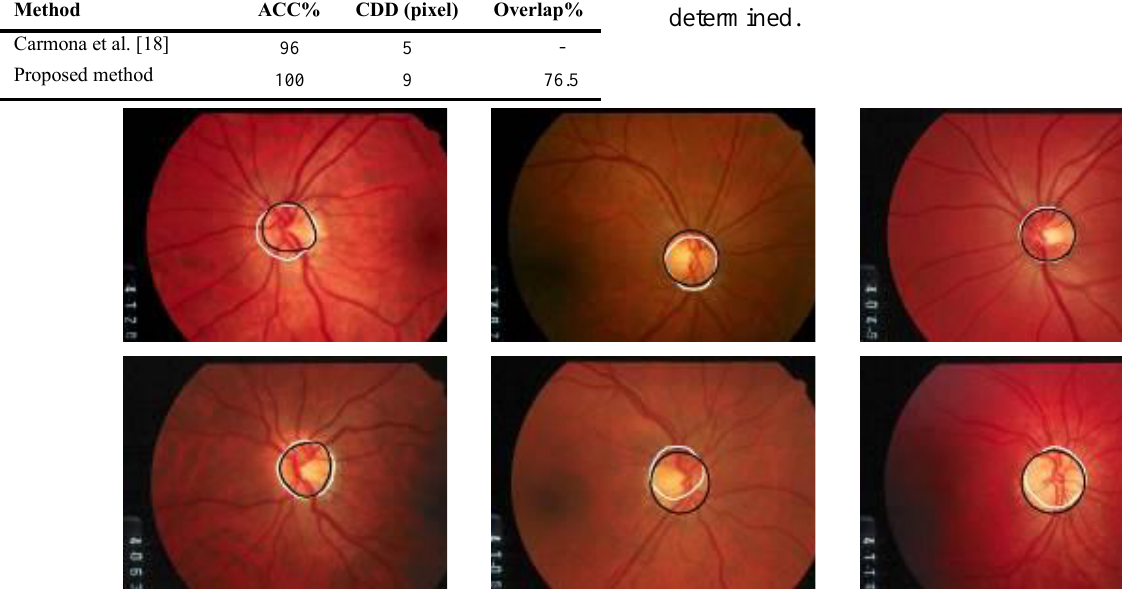
Table 2. Obtained performance on DRIONS database.